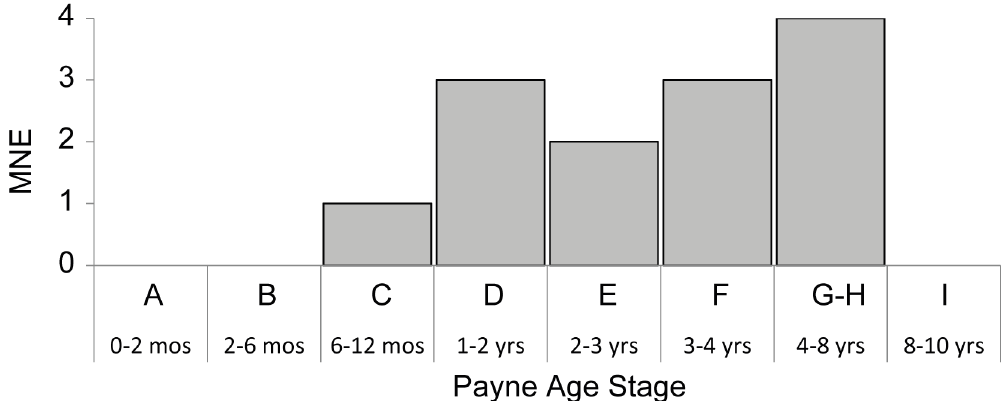
Fig 5. Capra mortality profile (n = 13), based on Payne's [57] tooth wear and eruption stages.